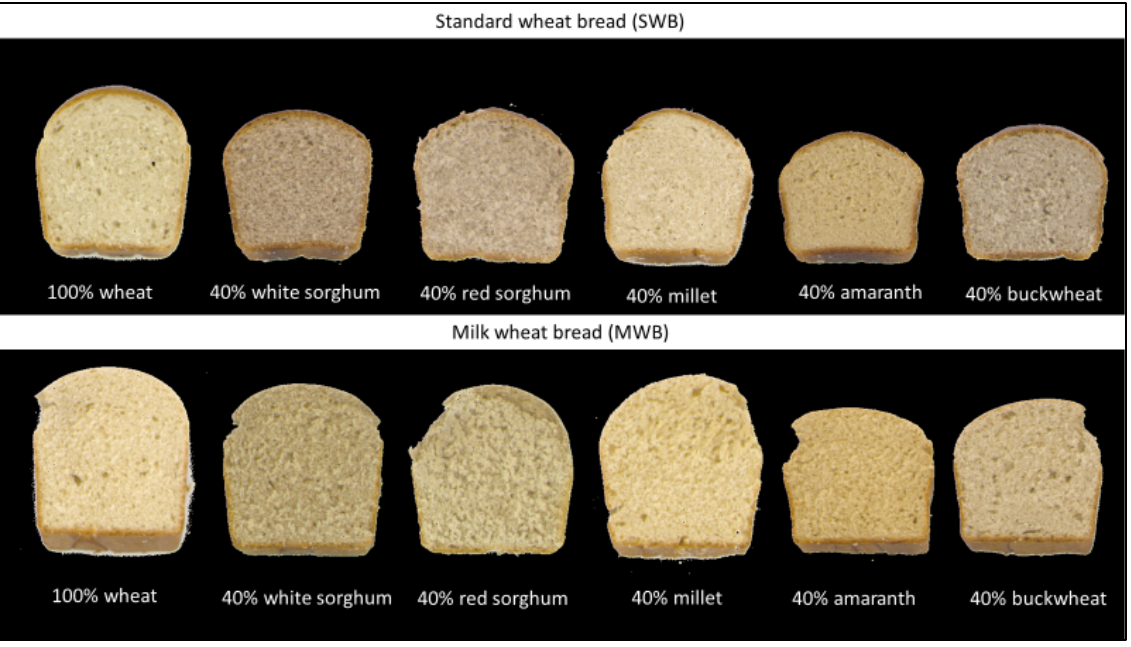
Figure 5. Bread slices of breads containing 40% alternative cereals and 60% wheat compared with the reference (100% wheat).